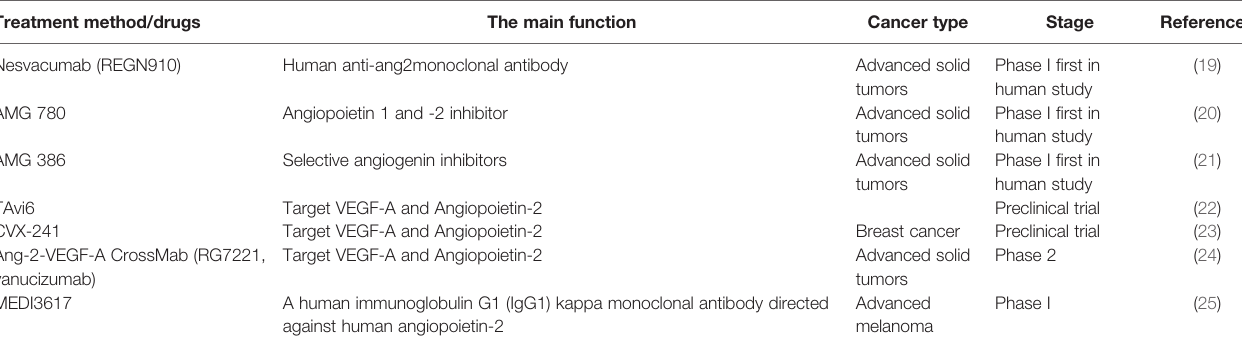
TABLE 1 | Targeted inhibition of ang2 in cancer